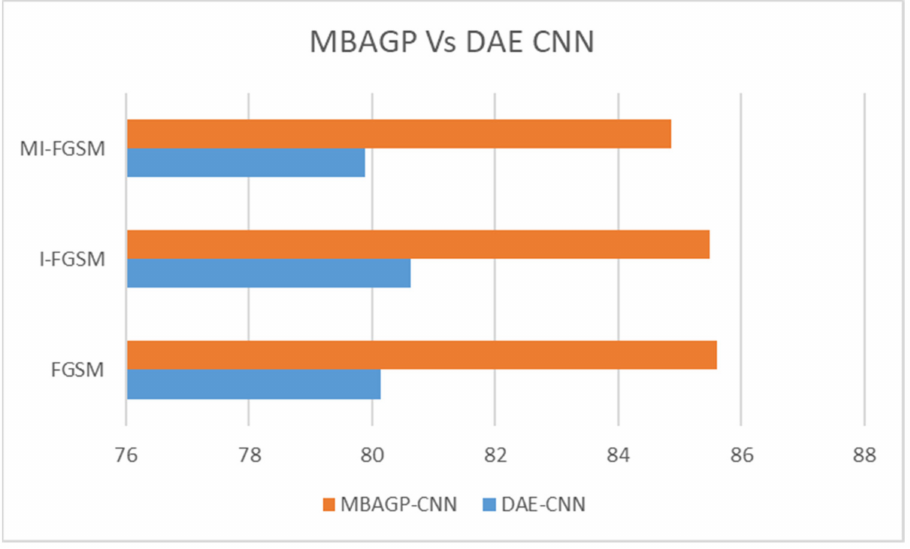
Figure 22. Comparison results of the testing accuracies obtained by the proposed MBAGP-CNN and the DAE-CNN defense models, based on FGSM, I-FGSM, and MI-FGSM